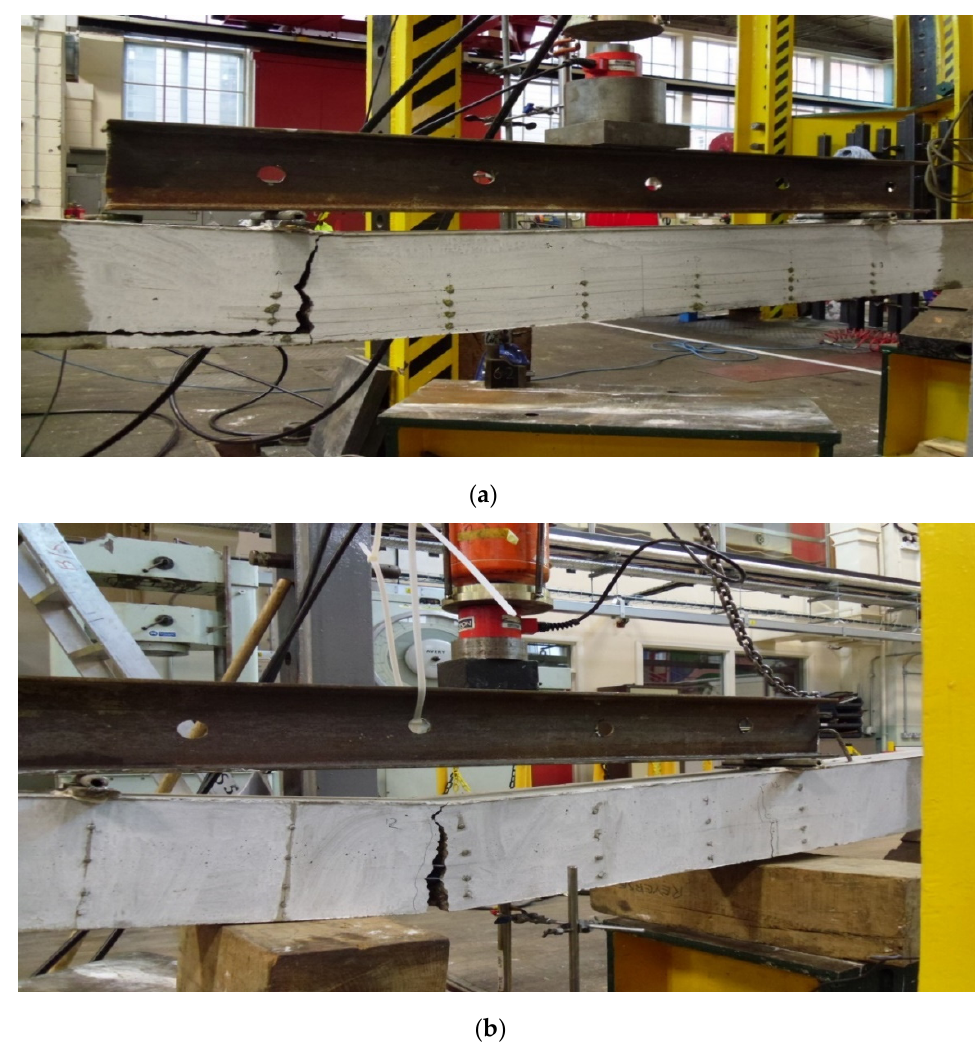
Figure 10. Mid-span load-deflection of straight end tow uni-axial TRC beams at different layers.